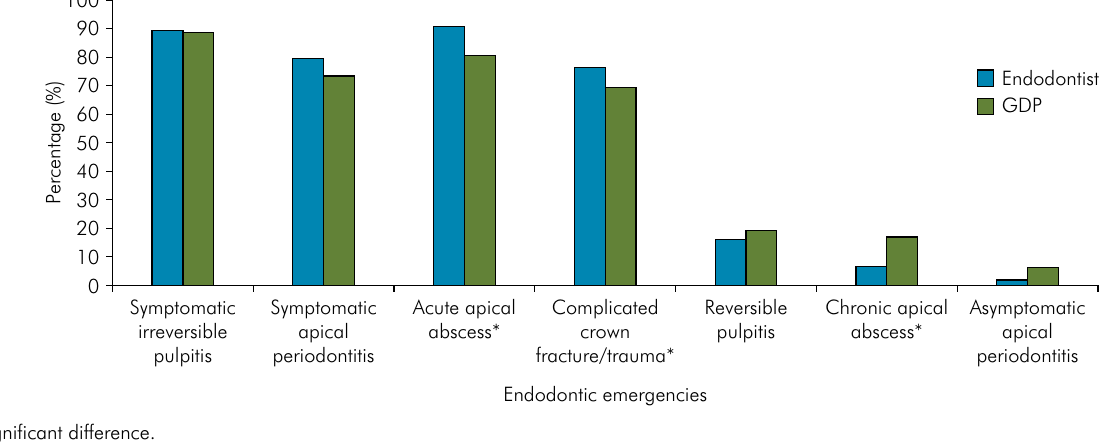
Figure 1. Percentages of the results regarding the considered diagnosis of endodontic emergencies by endodontists and general dental